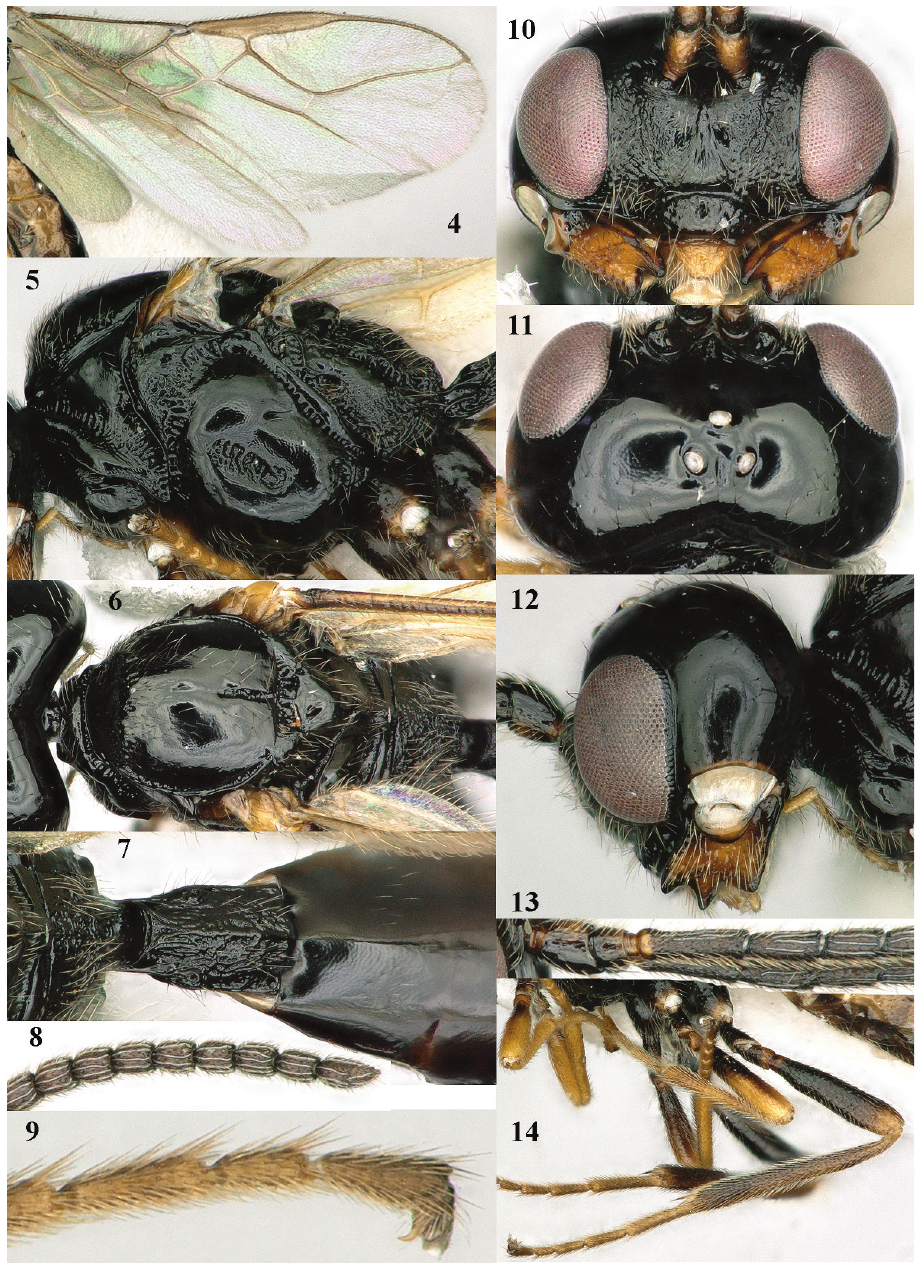
Figures 4–14. Grammospila martae sp. n., ♀ , holotype. 4 wings 5 mesosoma lateral aspect 6 mesosoma dorsal aspect 7 first-third metasomal tergites dorsal aspect 8 apical segments of antenna 9 outer hind claw 10 head anterior aspect 11 head dorsal aspect 12 head lateral aspect 13 basal segments of antenna 14 hind leg lateral